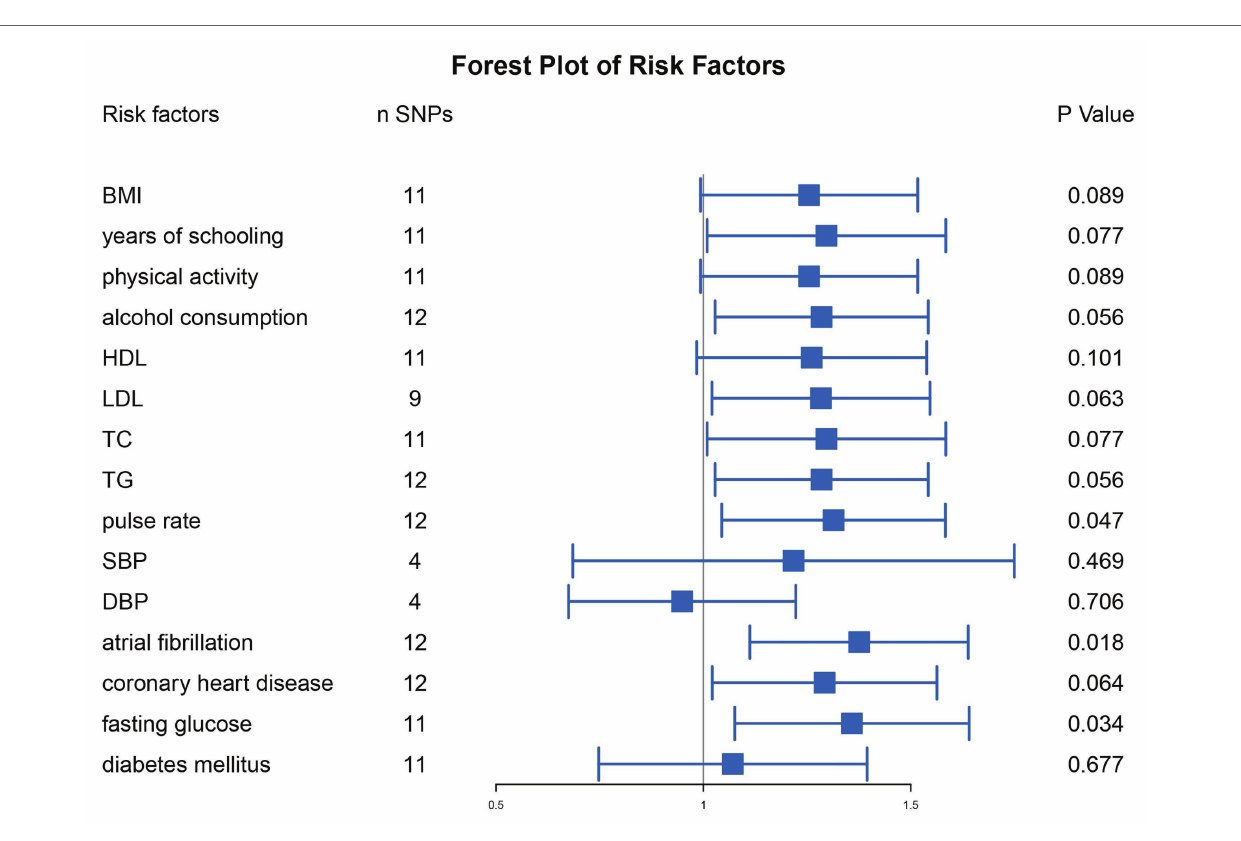
FIGURE 4 | Mendelian randomization analysis of plasma Hcy level on the risk of ischemic stroke caused by small artery occlusion after exclusion for the SNPs with significant differences of the known risk factors of ischemic stroke. SNPs, single nucleotide polymorphisms; BMI, body mass index; HDL, high-density lipoprotein cholesterol; LDL, low-density lipoprotein cholesterol; TC, total cholesterol; TG, triglycerides; SBP, systolic blood pressure; DBP, diastolic blood